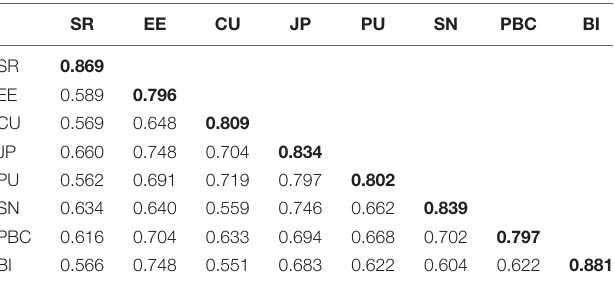
TABLE 2 | Discriminant validity of the measurement